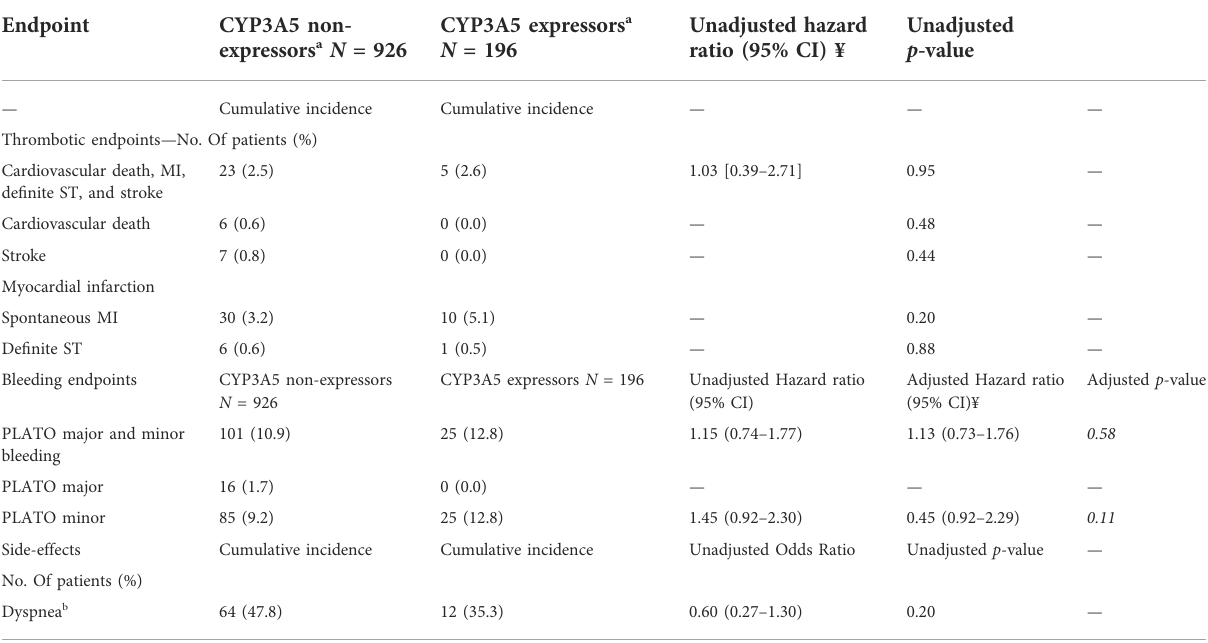
TABLE 3 Clinical Endpoint for CYP3A5 in patients treated with ticagrelor. Ticagrelor treated patients with CYP3A4*22 non-carriers